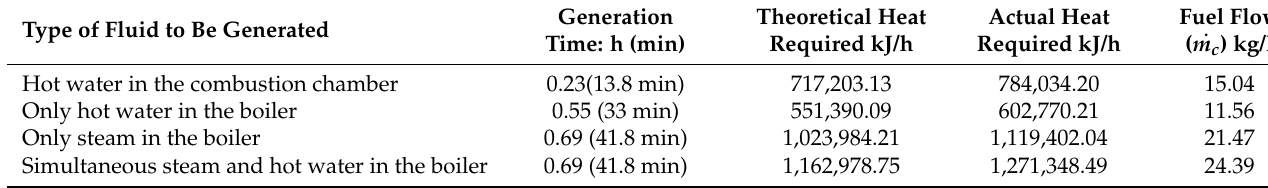
Table 5. Results of fuel consumption and heat requirements.